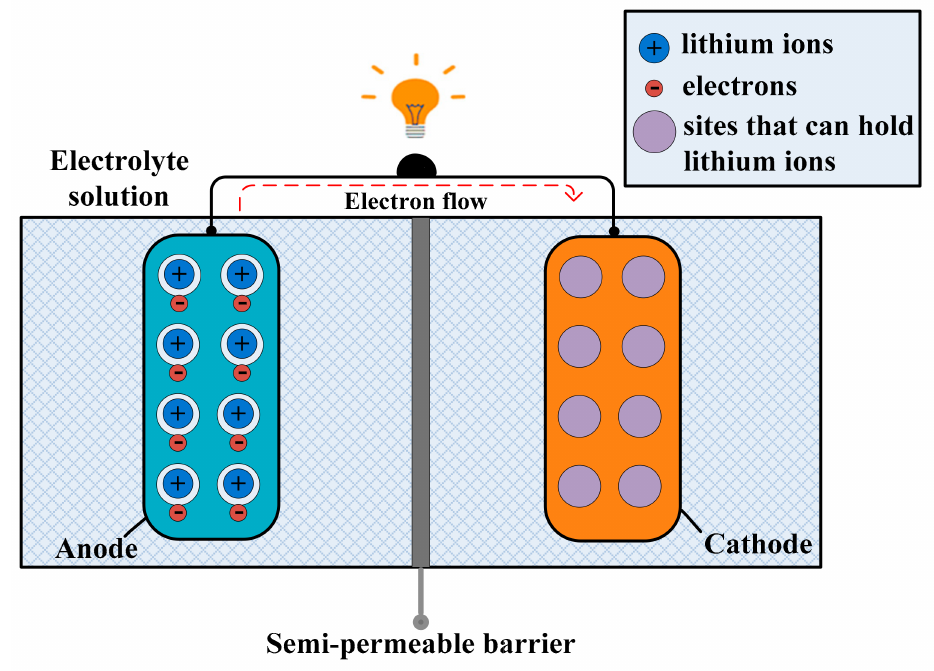
Figure 6. Working feature of lithium battery. Adapted from Ref. [78].